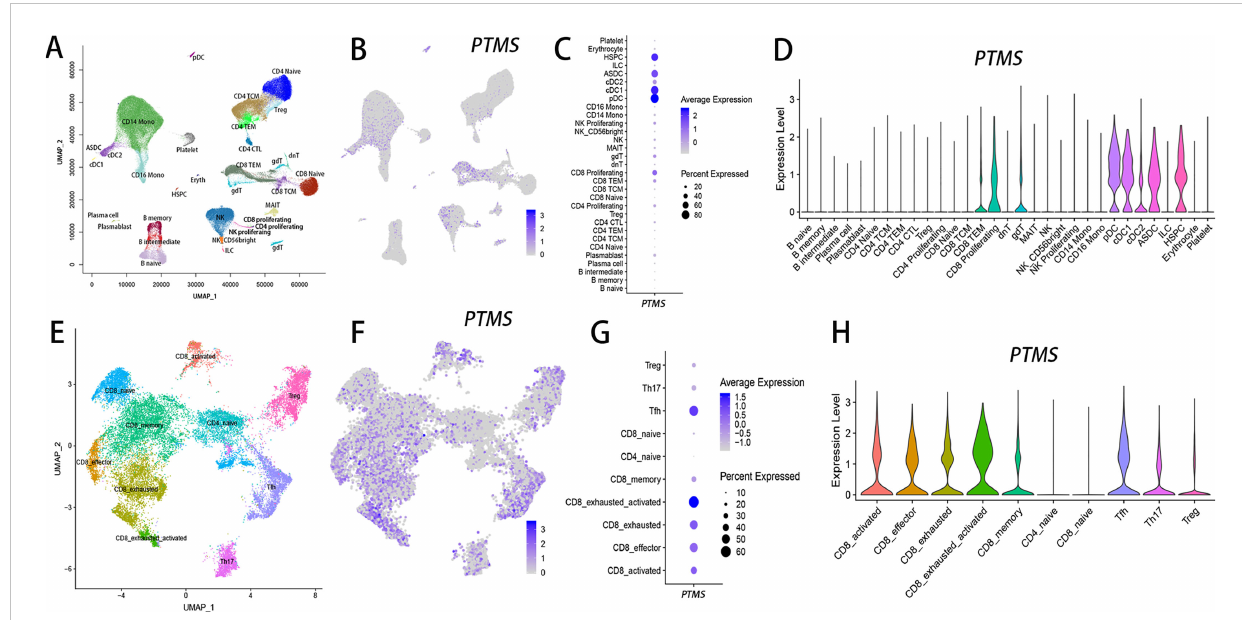
FIGURE 7 PTMS-positive T-cell subsets are enriched in squamous cell carcinoma (SCC) based on single-cell transcriptomic analysis. UMAP plots were used to show immune cell subsets in the datasets from multimodal human PBMCs (A) and SCC (E) . The expression levels of PTMS are illustrated by feature plots (B, F) , dot plots (C, G) and violin plots (D, H) in either PBMCs (B – D) or SCC (F – H)